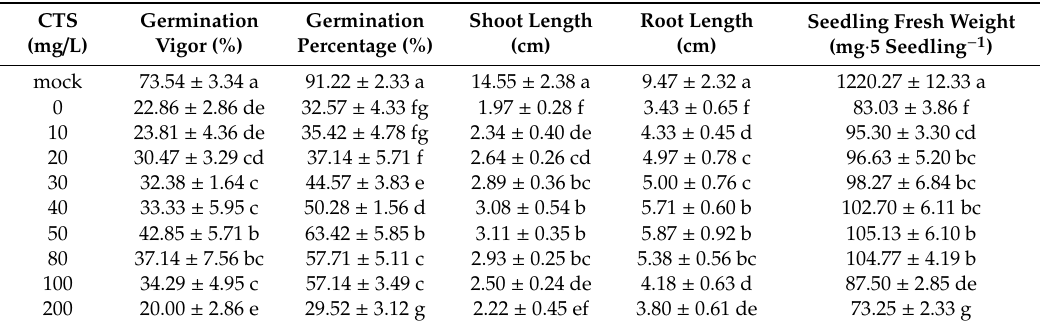
Table 1. Characteristics of annual ryegrass seed germination with water or increasing concentrations of CTS pretreatment under osmotic stress. Values are mean ± SD ( n =